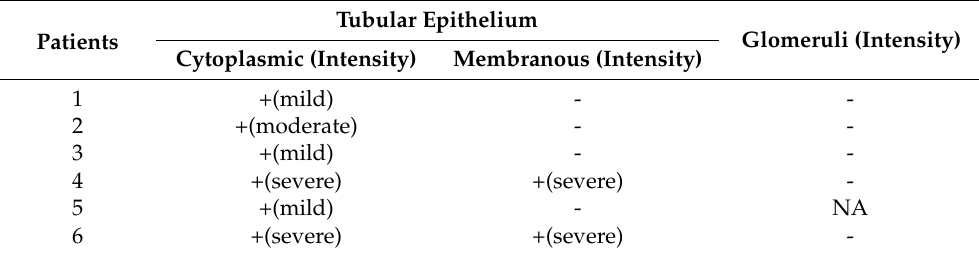
Table 4. The table summarizes PD ‐ L1 staining patterns in all twelve patients. Positive stain: +, negative stain: ‐ .